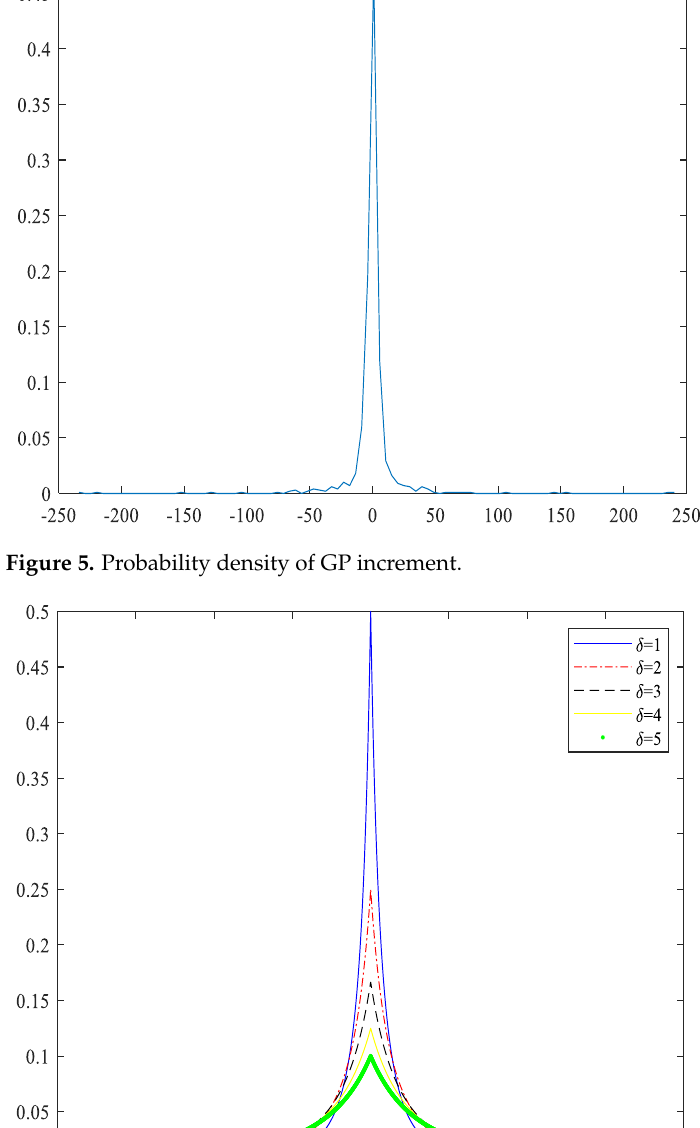
Figure 6. Comparison of δ value in GPD PDF plots. Figure 7. Comparison of value in GPD PDF plots. It can be seen from Figure 5 that the position parameter is 𝜇 = 0 in the generalized double Pareto distribution. And because when 𝑥 = 0, 𝑓(𝑥) = 1/2𝛿 , the probability value of 0 can be used to estimate 𝛿 . It can be seen from Figure 4, their peak value of the GPD